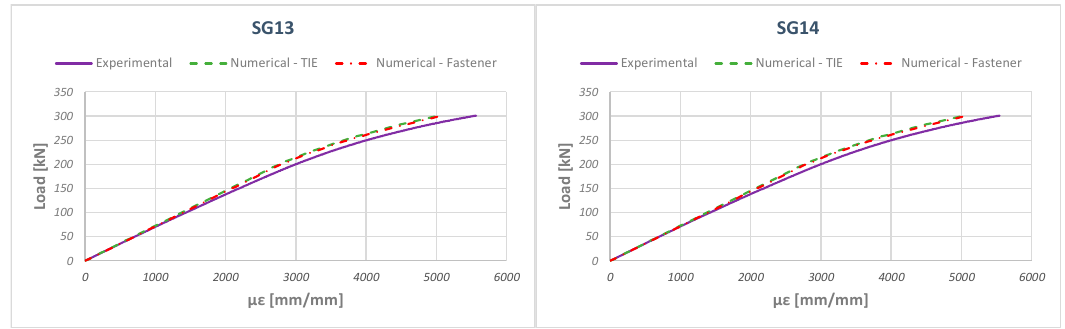
Figure 17. Numerical–experimental comparisons for SG-11 and SG-12: numerical TIE and Fasteners models.